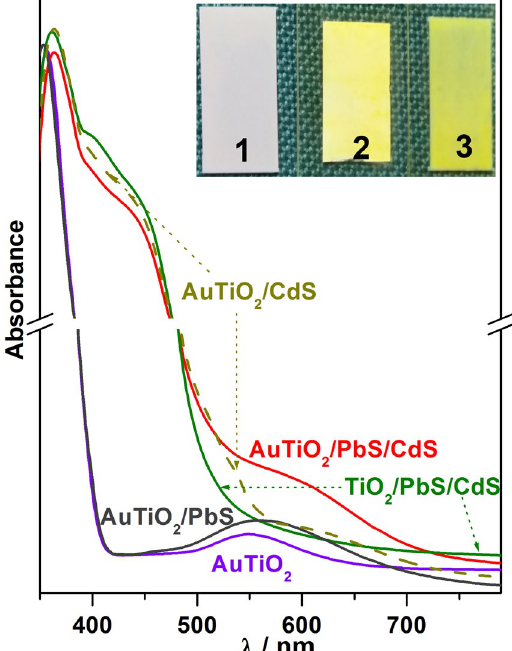
Figure 2. UV-Vis absorption spectra of the AuTiO 2 , AuTiO 2 /PbS, AuTiO 2 /CdS, TiO 2 /PbS/CdS, and AuTiO 2 / PbS/CdS photoanodes. Note the shift in absorption onset from AuTiO 2 at 560 nm to about 700 nm for AuTiO 2 / PbS/CdS. The inset shows a digital photograph of the colors associated with photoanode films, (1) AuTiO 2 and (2) TiO 2 /PbS/CdS, and (3) AuTiO 2 /PbS/CdS.